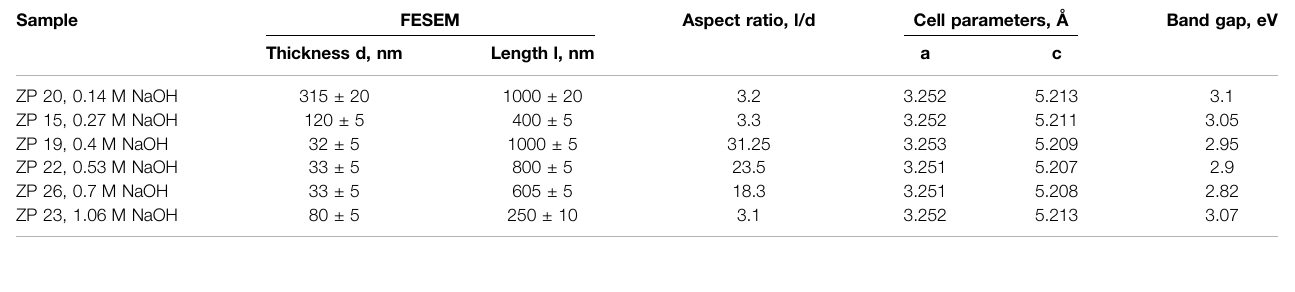
TABLE 1 | Physicochemical characteristics of the samples.